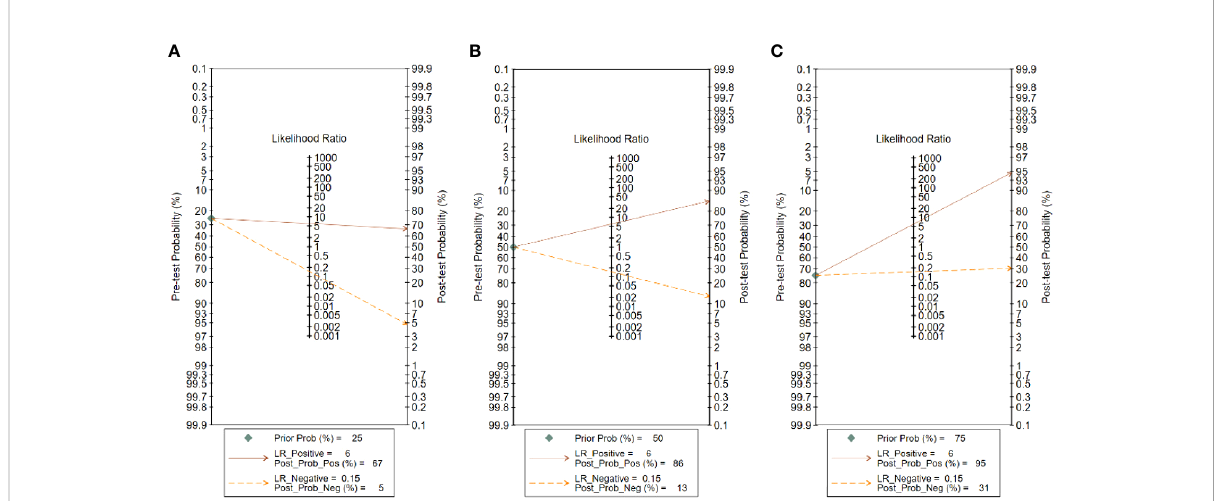
FIGURE 7 Fagan plot analysis for VGGNet model in detecting thyroid nodules: (A) Pre-test probability at 25%. (B) Pre-test probability at 50%. (C) Pre-test probability at 75%. The Fagan plot is composed of the left vertical axis representing the pre-test probability, the middle vertical axis representing the likelihood ratio, and the right vertical axis representing the post-test